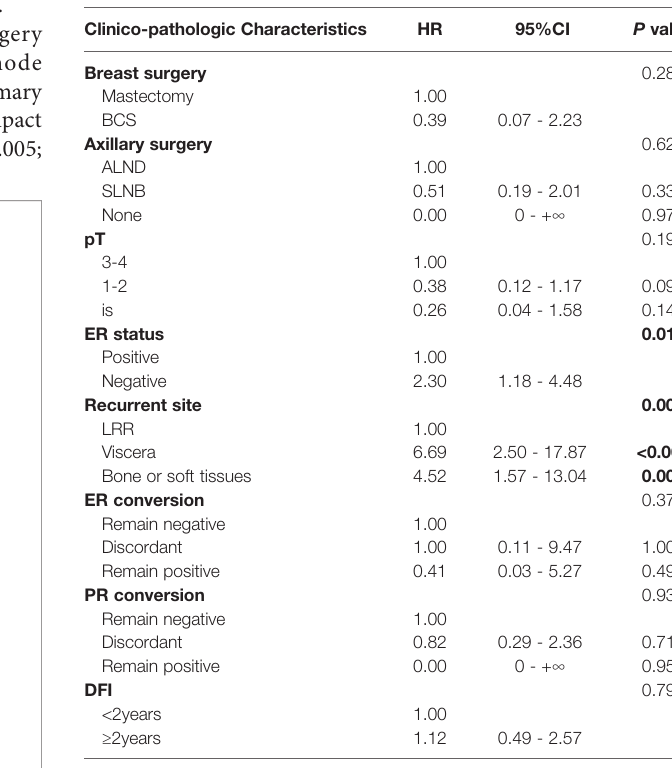
TABLE 3 | Multivariate analysis of factors associated with post-recurrence survival in breast cancer